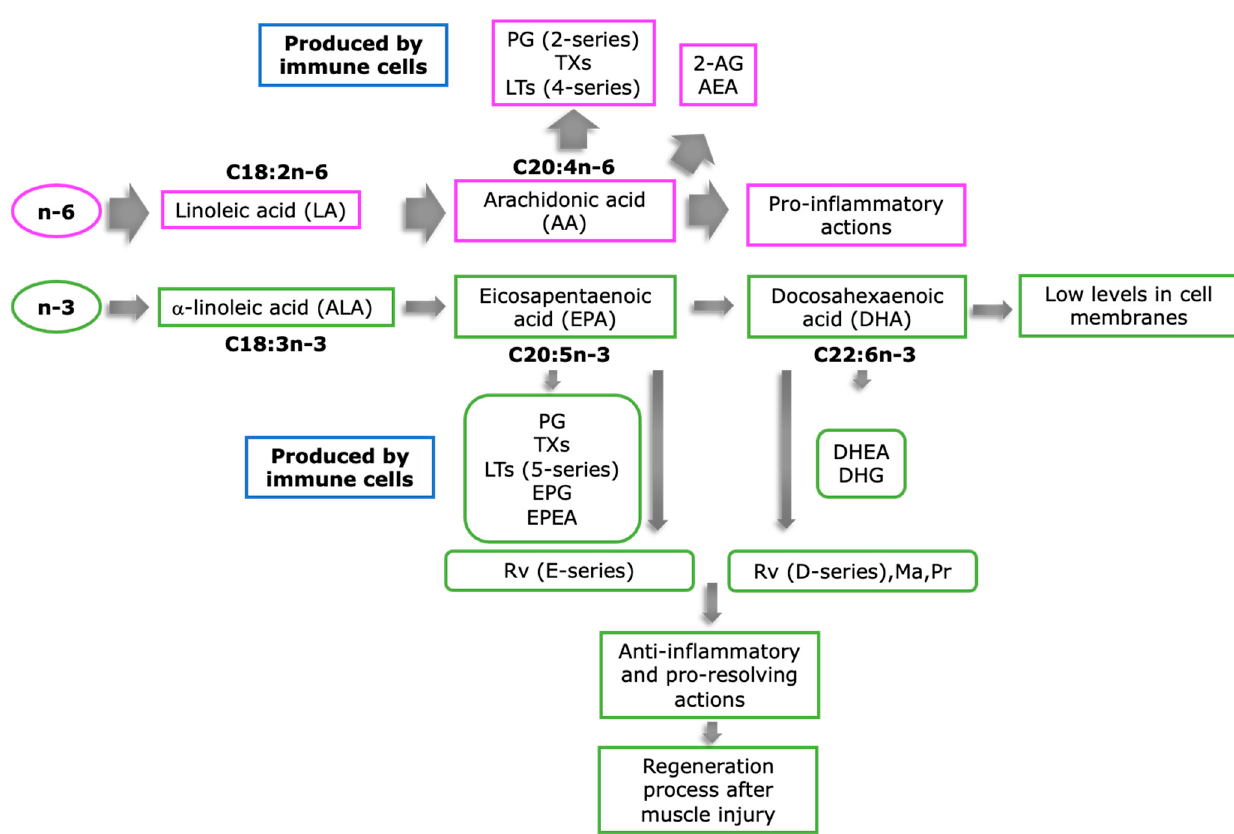
Figure 2. Omega-6 (n-6) and omega-3 (n-3) polyunsaturated fatty acid (PUFA) lipid mediators. The n-6 PUFA, linoleic acid (LA), is elongated and desaturated in the liver to arachidonic acid (AA). AA is processed by immune cells and converted into the two-series prostaglandins (PGs), thromboxanes (Txs), the four-series leukotrienes (LTs), and to the endocannabinoids, 2-acylglycerols (2-AG) and n-arachidonoylethanolamine (AEA). This metabolic pathway is associated with proinflammatory actions. On the other hand, the n-3 PUFA, α -linoleic acid (ALA), is elongated and desaturated in the liver to eicosapentaenoic acid (EPA) and docosahexaenoic acid (DHA). Immune cells convert EPA to the three-series PG, TXs, five-series LTs, to the endocannabinoids, eicosapentanoylglycerol (EPG), eicosapentaenoylethanolamide (EPEA), and to the e-series derived resolvins (Rv). DHA is converted to docosahexaenoyl ethanolamide (DHEA) and docosaheanoyl-glycerol (DHG) and to the D-series Rv, maresins (Ma) and protectins (Pr). The n-3-derived lipid mediators have anti-inflammatory and proresolving actions, which may accelerate the muscle regeneration process.